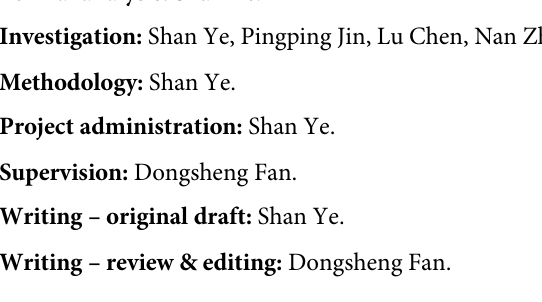
S1 Fig. Minimal data set for Fig 1. S2 Fig. Minimal data set for Fig 2. S3 Fig. Minimal data set for Fig 3. S4 Fig. Minimal data set for Fig 4. (XLSX) S5 Fig. Minimal data set for Fig 5. (XLSX) S1 Table. Minimal data set for Table 1. (XLSX) S2 Table. Minimal data set for Table 2. (XLSX) S3 Table. Minimal data set for Table